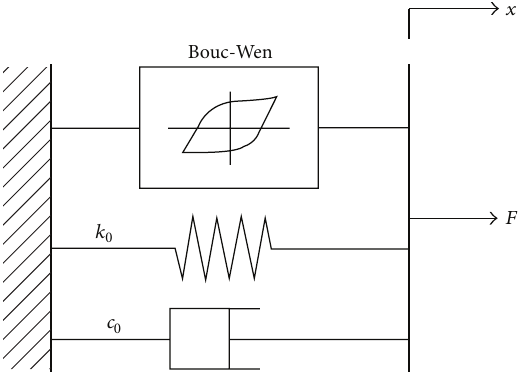
Figure 18: Simple Bouc-Wen model for MR dampers [15, 17].